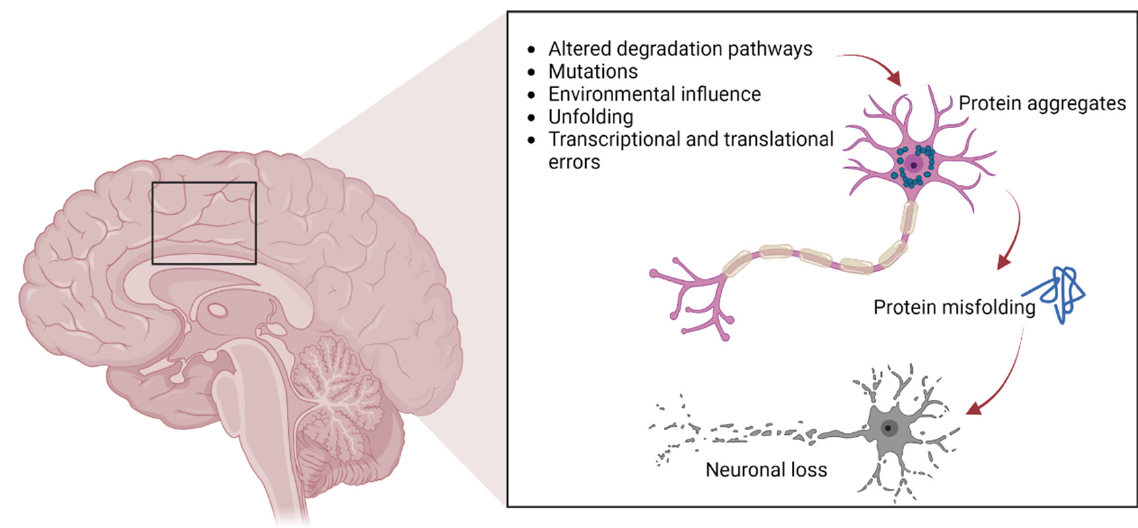
Figure 1. The pathways involved in protein aggregation in neuronal cells, leading to neuronal death typically found in neurodegenerative diseases .